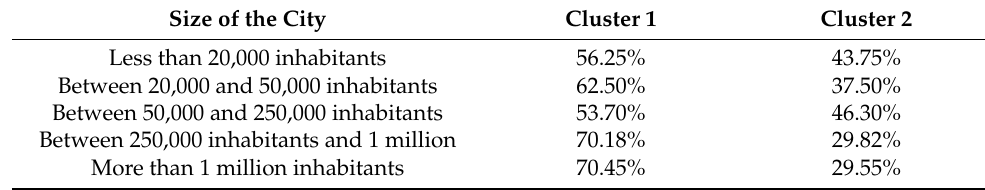
Table 2. Proportion of respondents from each cluster based on the size of the city in which they live. Size of the City Cluster 1 Cluster 2 Less than 20,000 inhabitants 56.25%